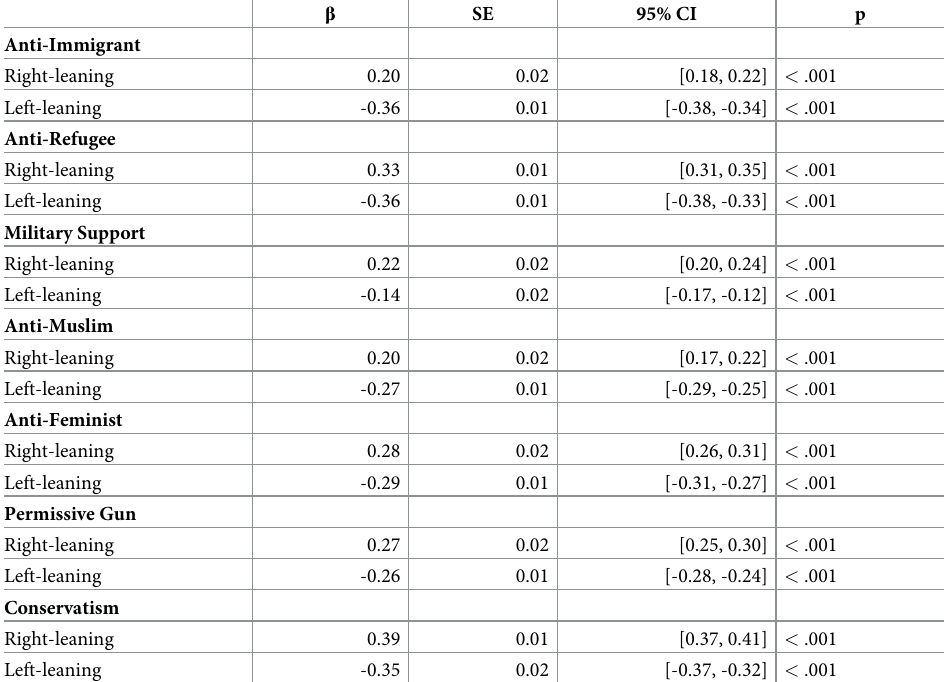
Table 2. Regression analysis predicting attitude positions (nationally representative cross-sectional